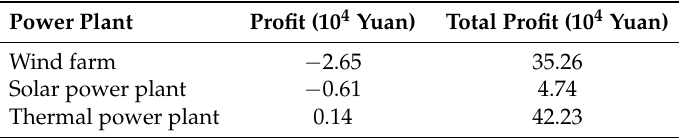
Table 5. Profit of the power producers in the intraday market.